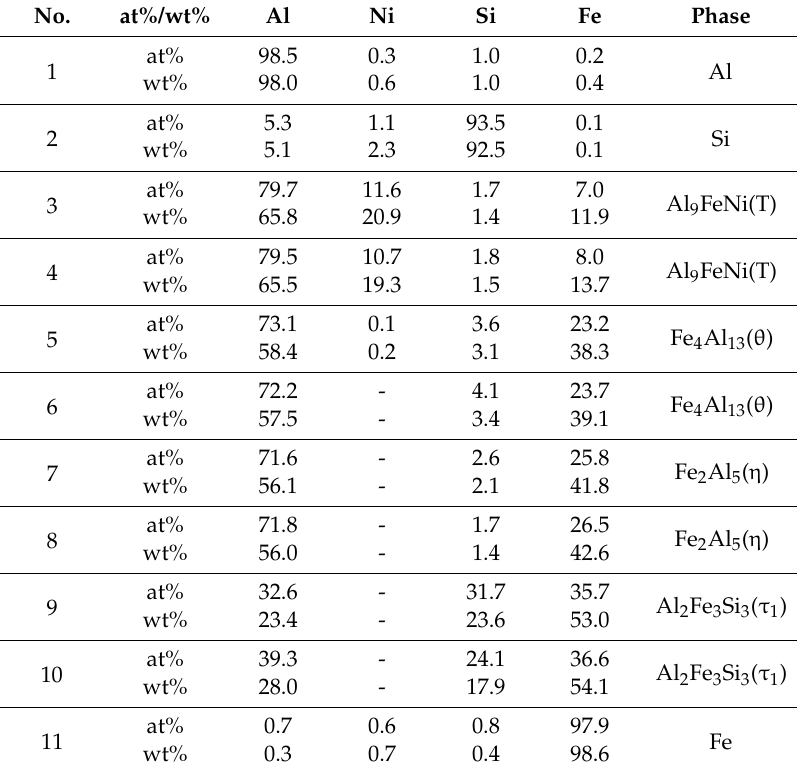
Table 4. EDS analysis results of phases denoted as 1–11 in Figures 6 and